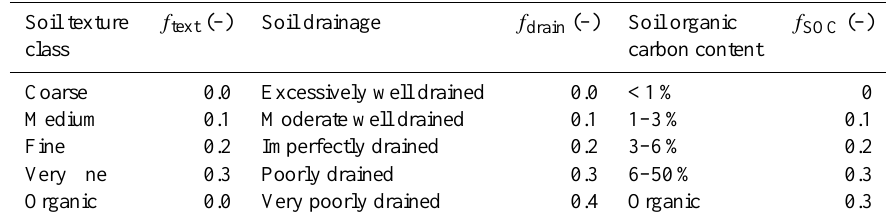
Table 2. Denitrification fractions for soil texture, soil organic carbon and soil drainage. Soil texture f text